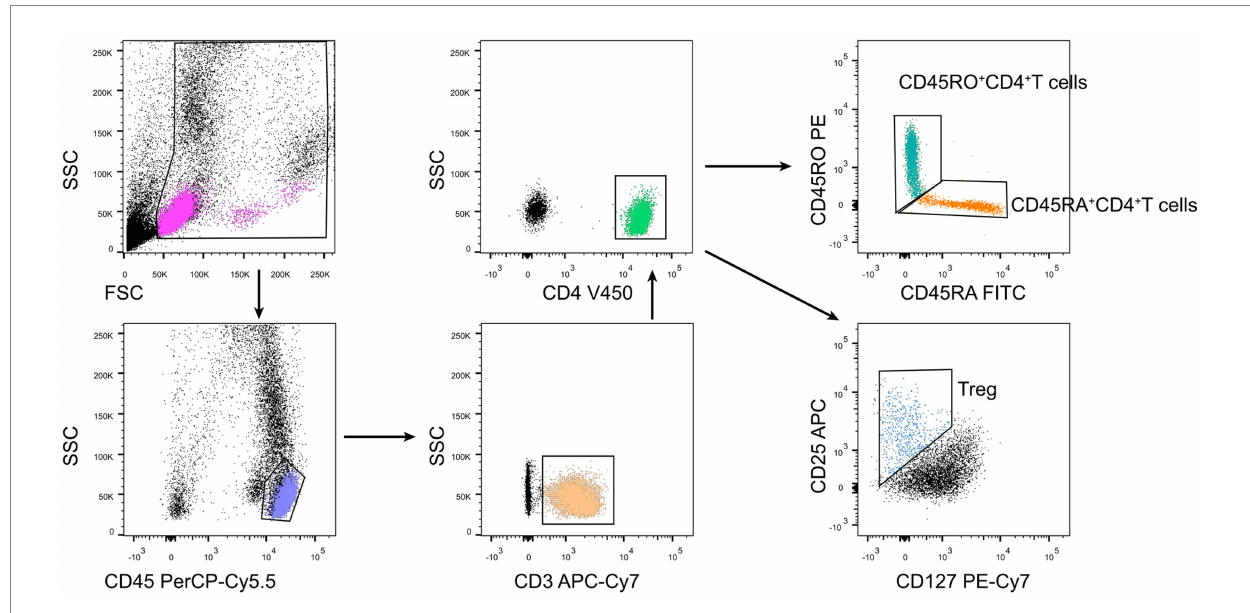
FIGURE 1 The gating stratege for Treg phenotype